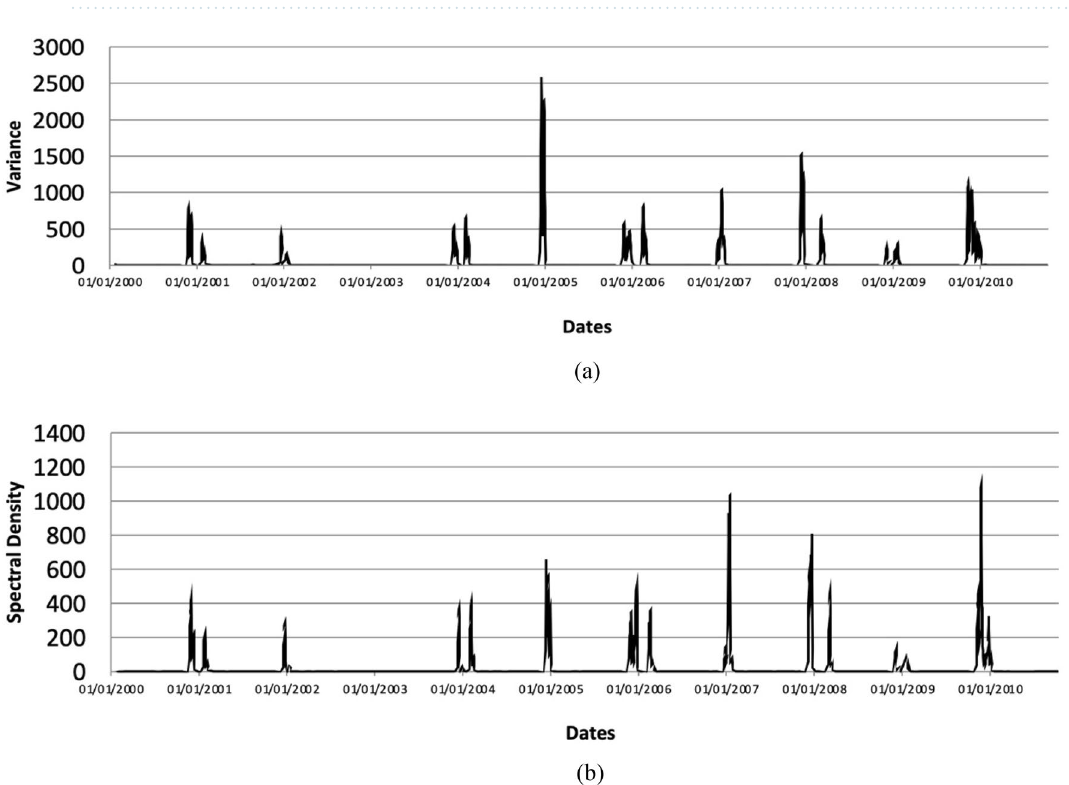
Figure 7. Time series of CSD indicators for early warning signals based on the PH framework—( a ) variance and ( b ) average spectral density at low frequencies of the time series of the L persistence